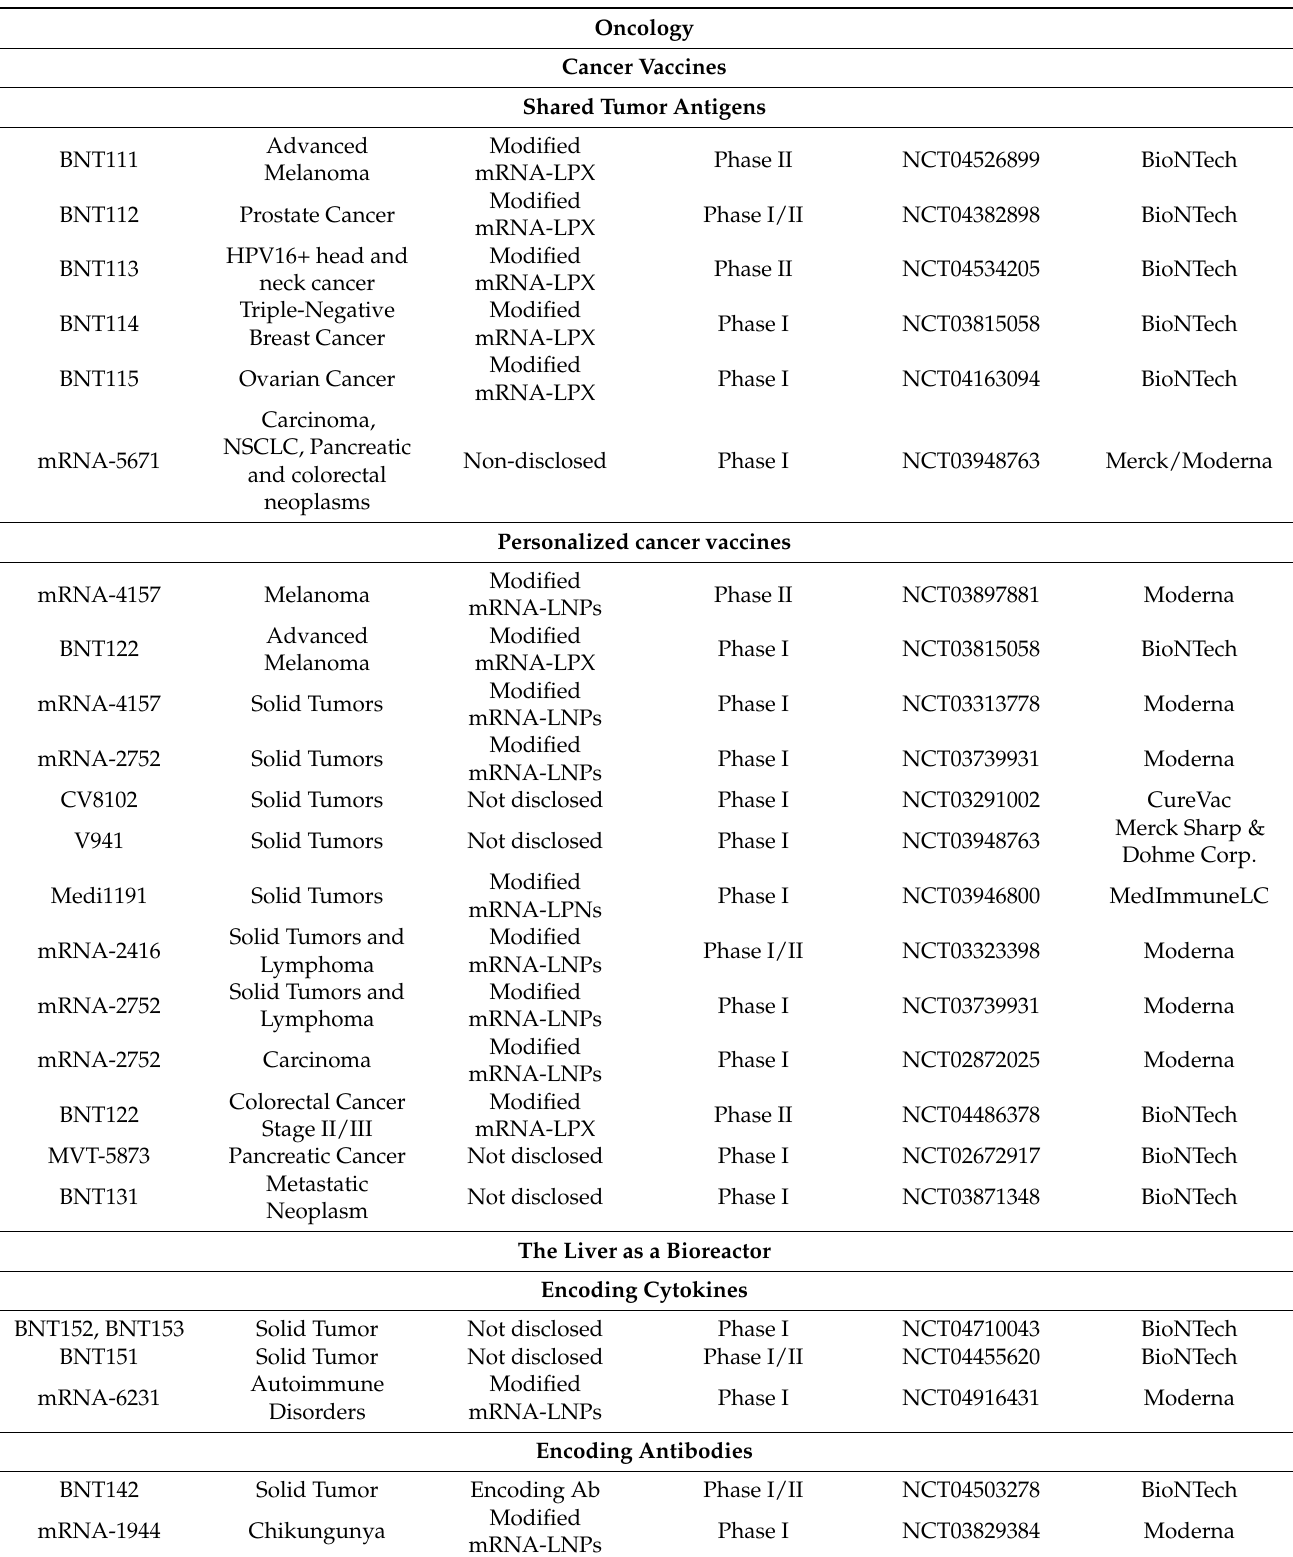
Table 2. mRNA Nanomedicines for Oncology in Clinical Trials. A list of clinical trials for oncology applications, including the subsections described above, is provided in this